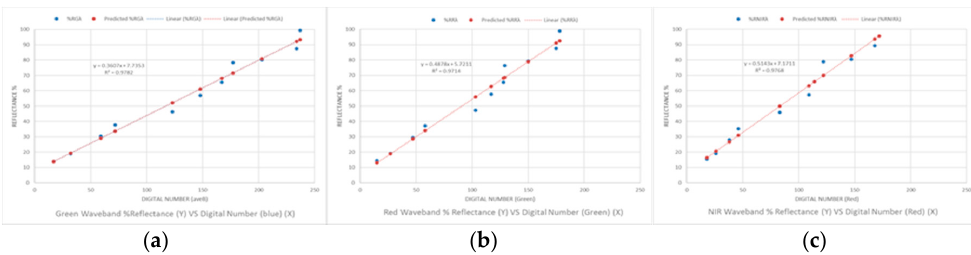
Figure 4. Plots of: Green ( a ); Red ( b ); and NIR ( c ) camera response functions for the Dulux targets.